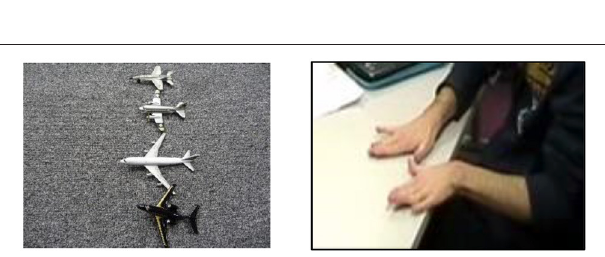
FIGURE 8 | This participant is using a novel handshape to gesture planes lying side by side.